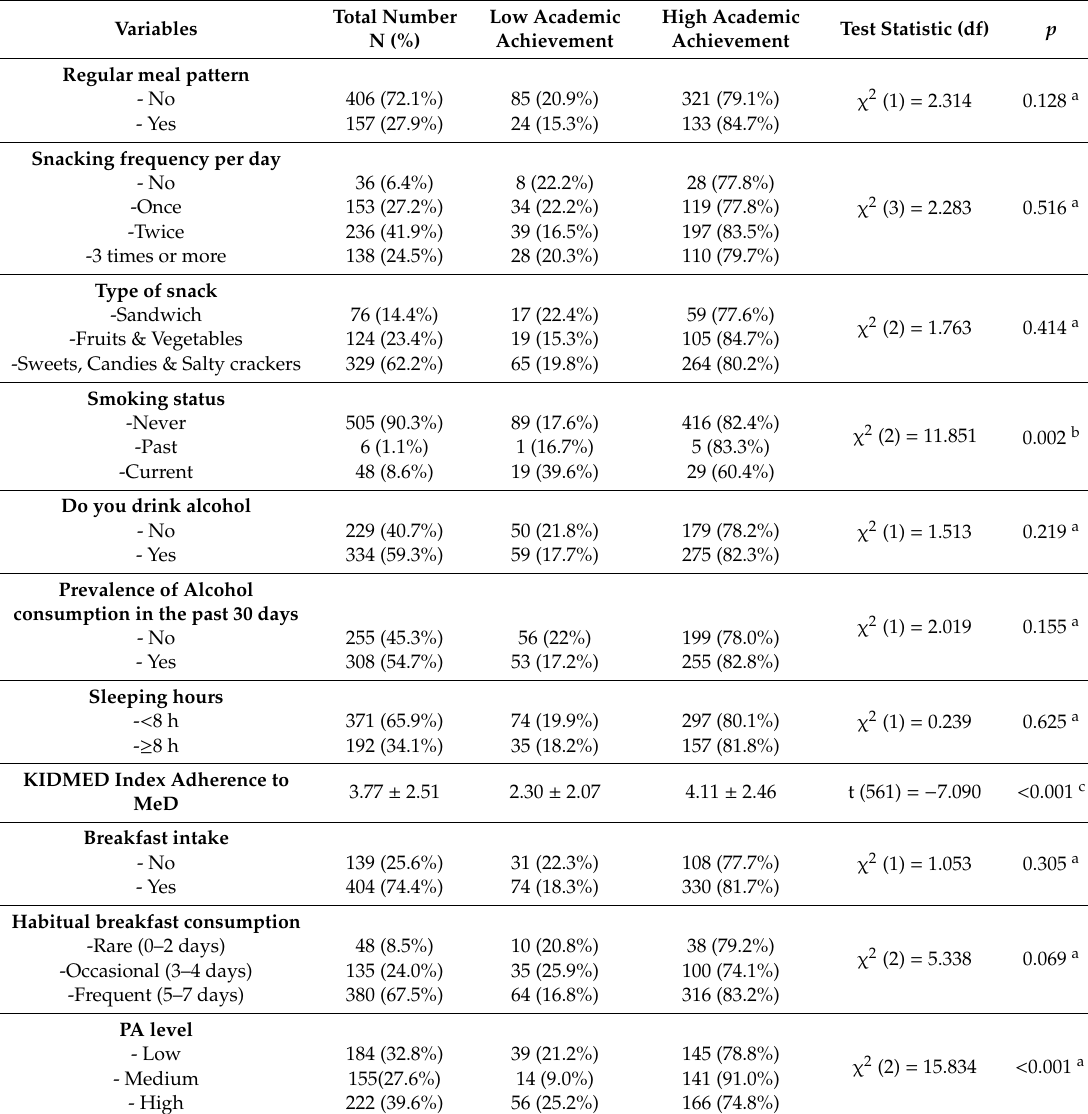
(Table 2). No significant associations of academic achievement with snacking frequency and type, alcohol consumption and breakfast intake were found. Table 2. Association between Health Behaviors and Academic